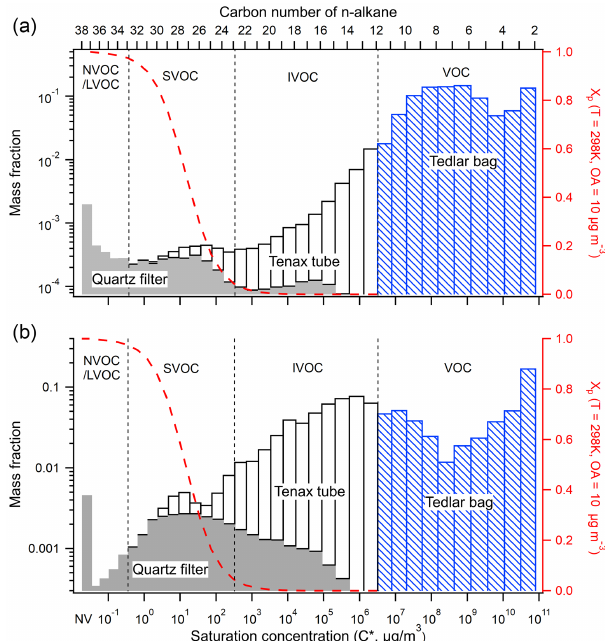
Figure 1. Volatility distribution of organic emissions for a typi- cal (a) gasoline (b) diesel vehicle. The emissions are classified by sampling media (line 1: Tedlar bag, line 2: bare quartz filter fol- lowed by two Tenax tubes). The red dashed line indicates the parti- cle fraction assuming the emissions form a quasi-ideal solution at a C OA of 10µgm − 3 and temperature of